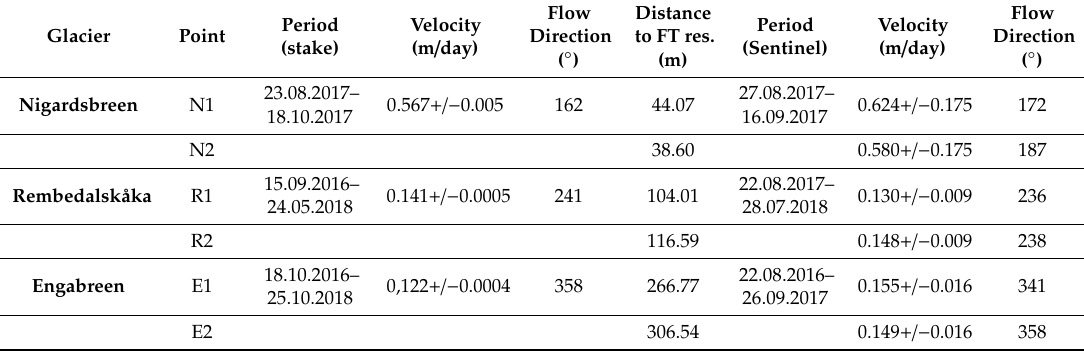
Table 1. Comparison of velocities from Sentinel-2 feature tracking using SenDiT and stake in-situ